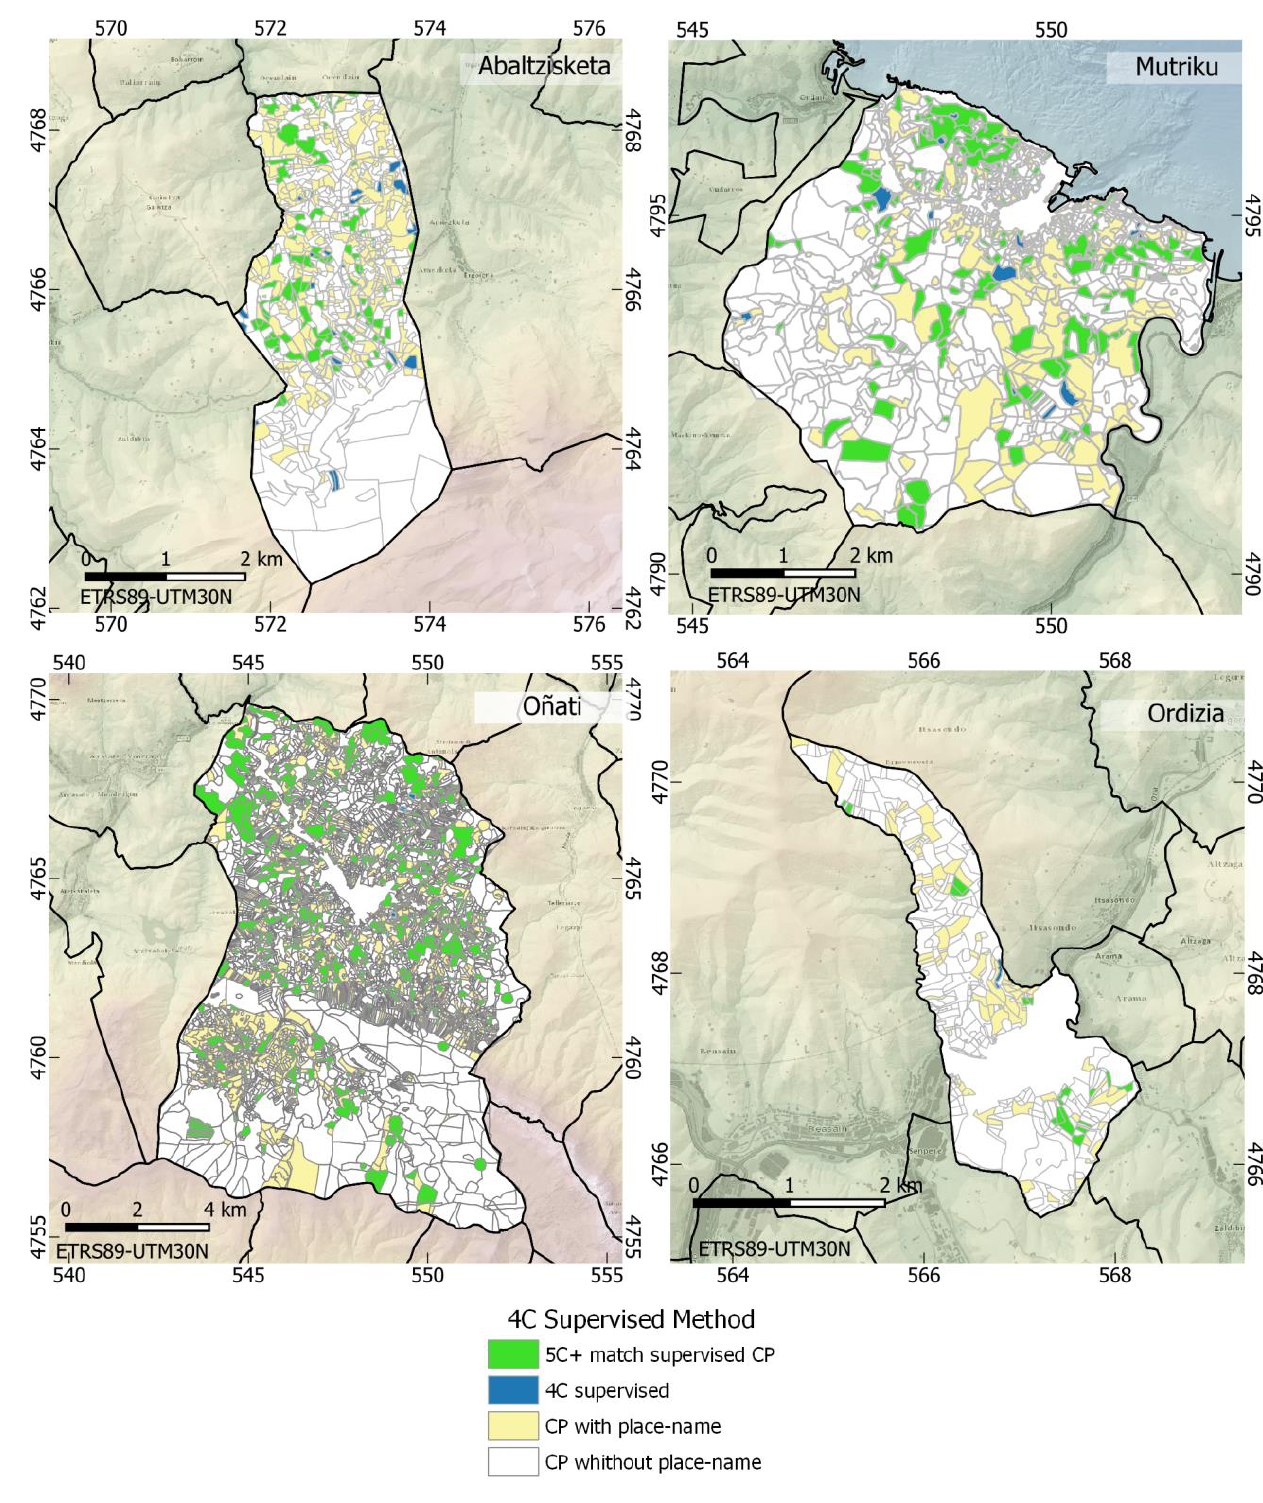
Figure 6. Cadastral parcels selected by supervision (4C and 5C+ matching). Frame coordinates in km.